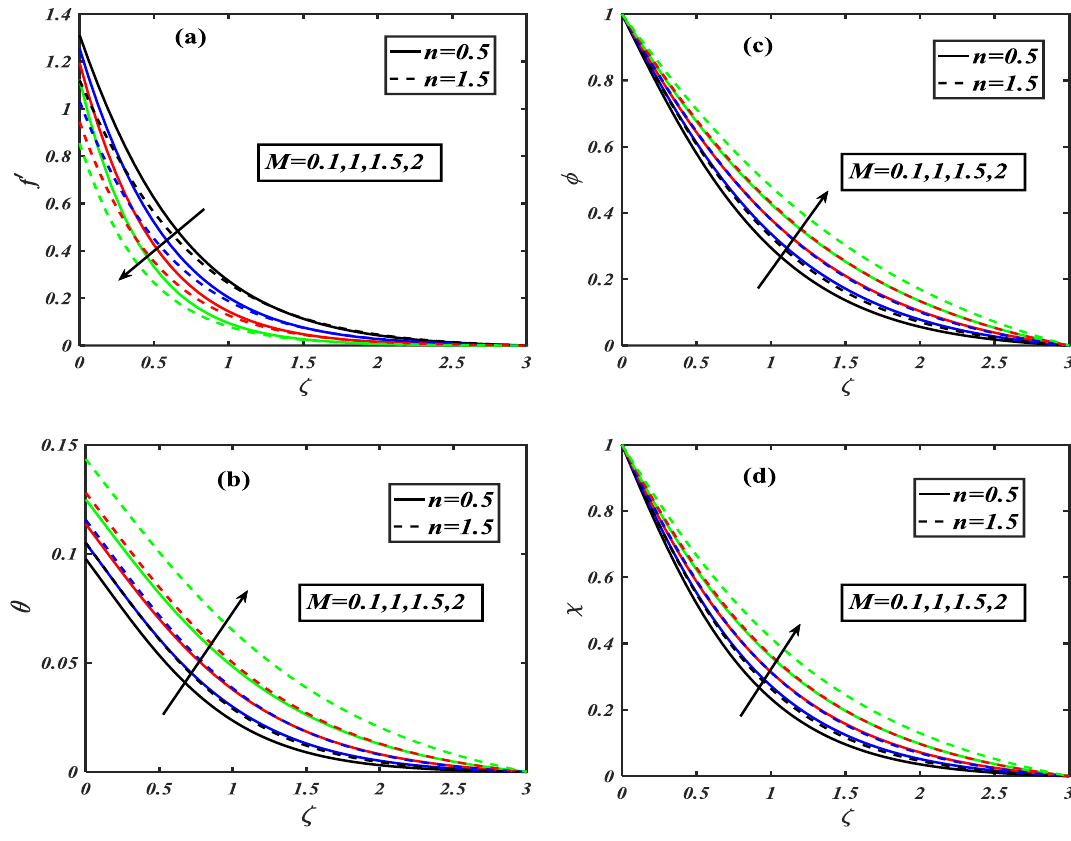
Figure 5. ( a – d ) Illustrates the effect of magnetic parameter on f ′ (ζ) , θ(ζ) , φ(ζ) & χ(ζ) .